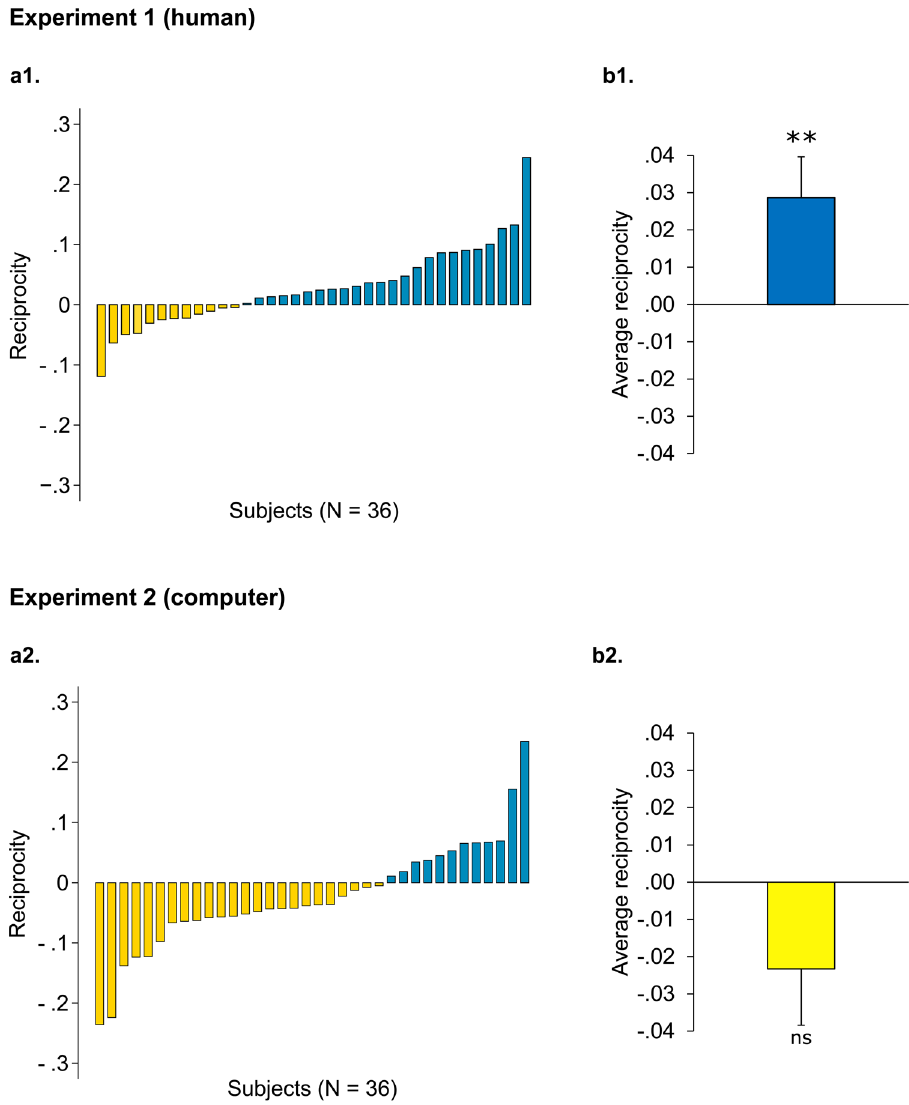
Figure 4. Results of the Indirect Reciprocity task in Experiment 1 ( a1 , b1 ) and Experiment 2 ( a2 , b2 ). ( a1 , a2 ) Reciprocity index, computed as mean influence in the Susceptible condition minus mean influence in the Insusceptible condition (in decision turns), plotted across participants. Negative values (in gold) represent participants who show anti-reciprocal behavior, while positive values (in blue) represent individuals who show indirect reciprocity and therefore increased the level of influence taken from the passive agent in the Susceptible condition. ( b1 , b2 ) Average reciprocity index in Experiment 1 and Experiment 2. Error bars represent between- subject standard error of the mean. ** p < 0.01, ns: not significant. Effect of condition in Mixed-effect